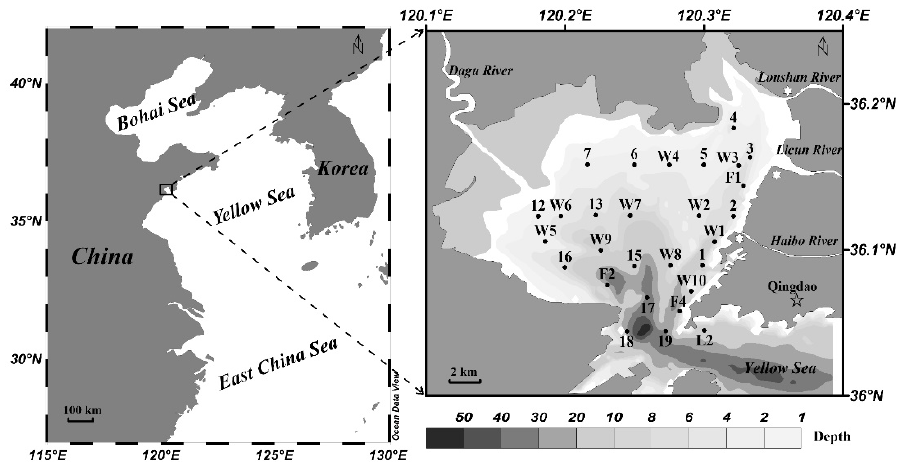
Figure 1. Study area and sampling stations. Solid circles represent the sampling stations, and solid white stars represent wastewater treatment plants (WWTPs). The grey scale shows the bottom seawater depth.